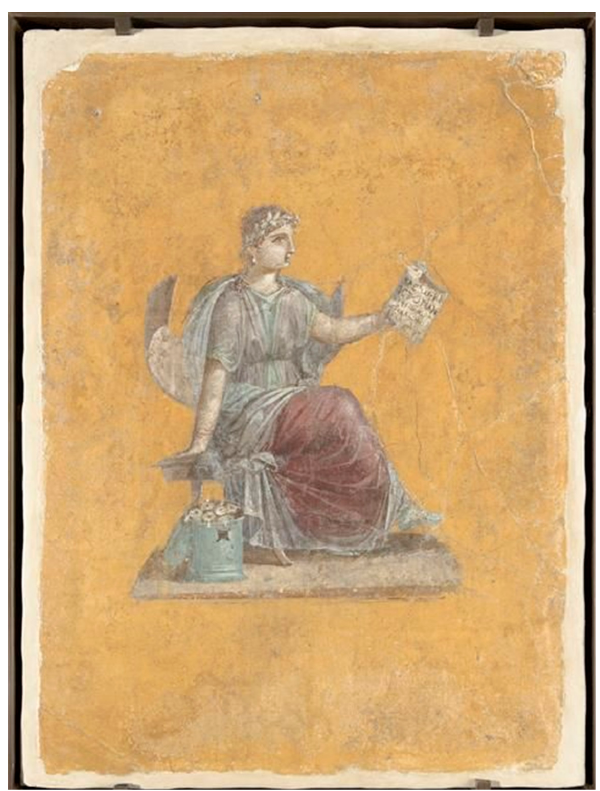
Figure 11. Pompeii, Praedia of Julia Felix (II.4.3), fresco of Clio, the Muse of History, now at the Louvre (photo by the author).